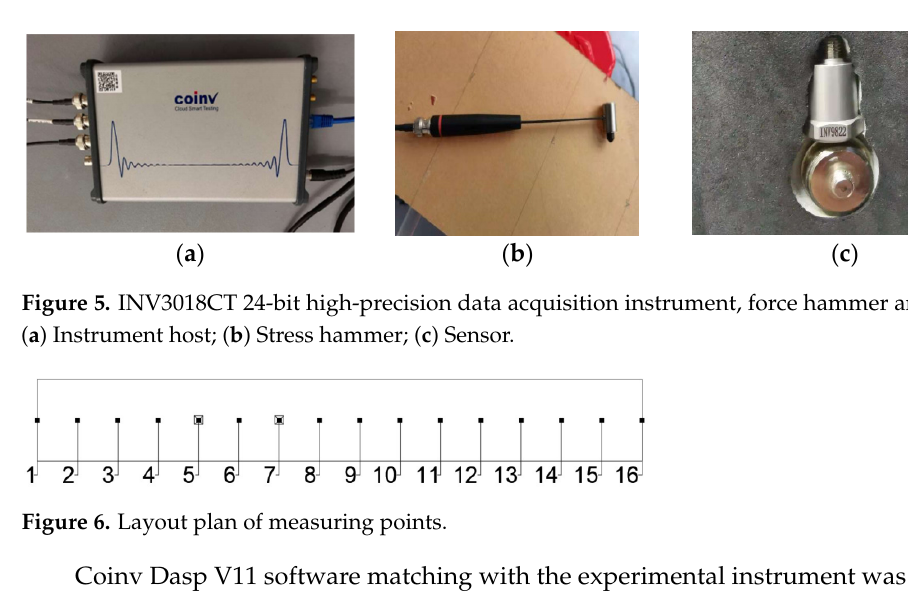
Figure 5. INV3018CT 24-bit high-precision data acquisition instrument, force hammer and sensor. ( a )Instrument host; ( b )Stress hammer; ( c )Sensor.